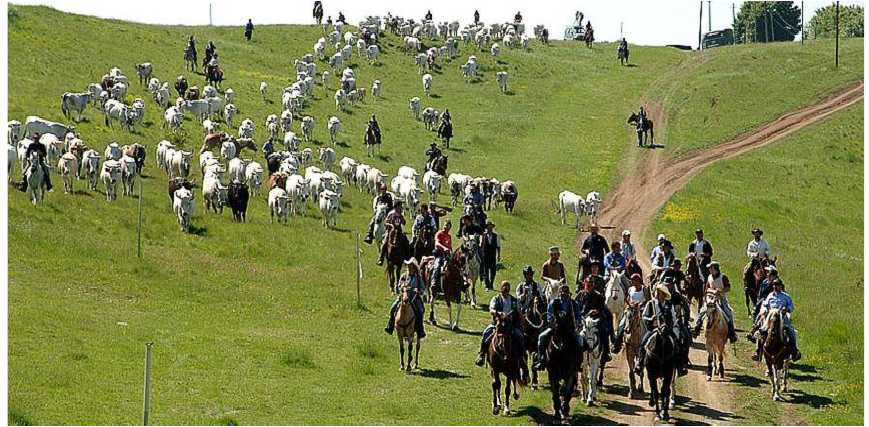
Figure 1. Men, animals, and territory: the three elements of transumanza , an ancient traditional type of grazing in upper Molise, Italy, included in the cultural heritage list in 2019 by UNESCO [2].